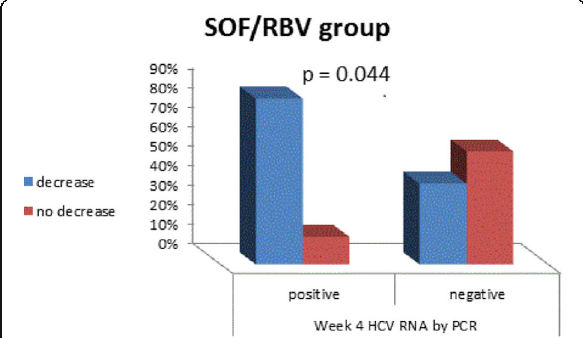
Fig. 2 Comparison between change in the platelet count in week 4 and HCV RNA by